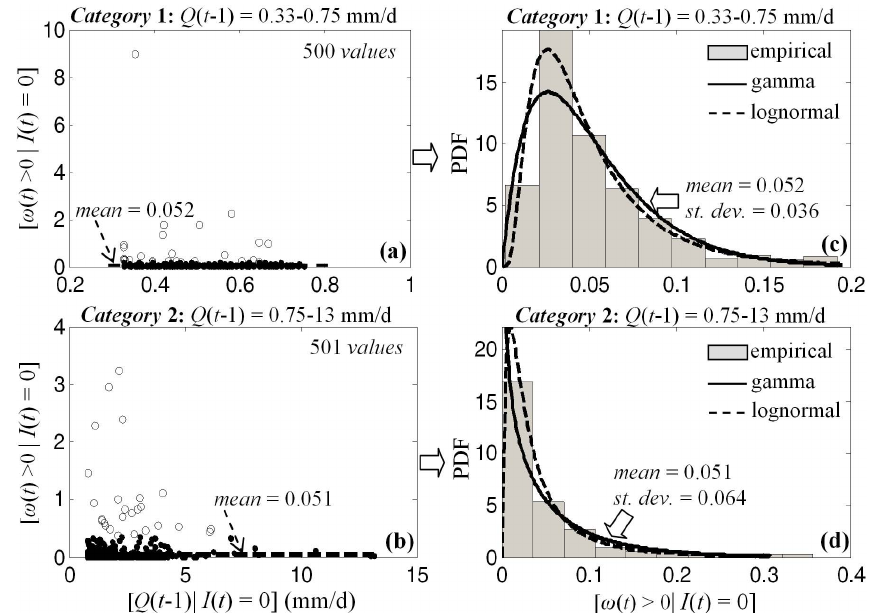
Fig. 3. (a, b) Scatter plots of the empirical ratios [ ω(t)> 0 | I(t) =0], calculated using daily discharges and rainfall data from the hydroelectric plant (HP; point A in Fig. 2) for the period 1 October 1974–30 September 1993 (i.e. 19yr, 1001 points) and split into 2 equally populated categories with respect to the previous-day river discharge Q(t − 1). Empty circles indicate values of ω for which the null hypothesis of no rain over the catchment is rejected at the 5% significance level; see main text. (c, d) Empirical histograms of the ratios (dots) in (a) and (b) fitted by gamma (solid lines) and lognormal (dashed lines) distribution